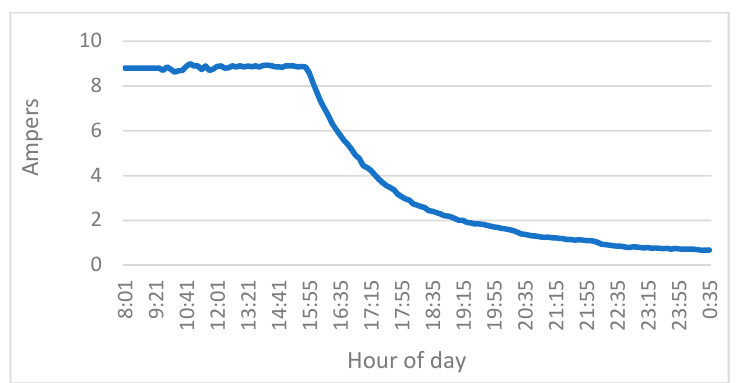
Figure 35. BB voltage in charging mode.